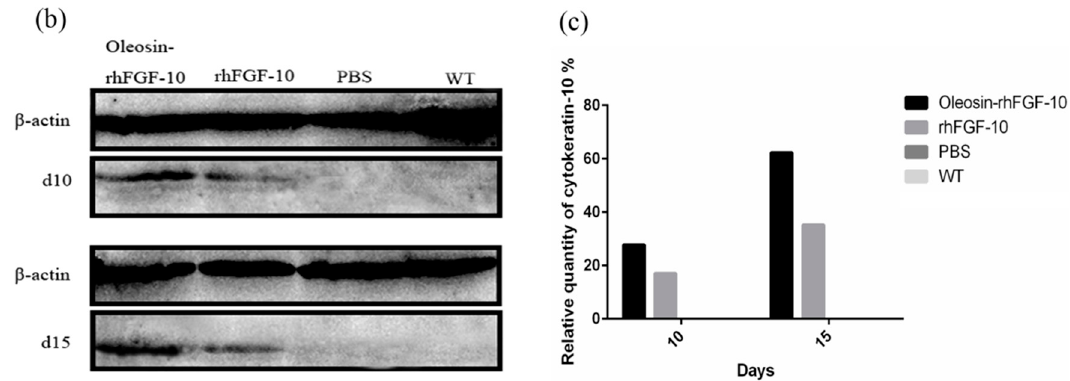
Figure 6. ( a ) Immunohistochemical assay with thecytokeratin-10 in wounds of the four groups. The cytokeratin-10 was detected in regenerated epidermis. The images are shown at 40 × and 100 × magnification; ( b , c ) western blot quantification method for objective evaluation for expressing cytokeratin-10 in regenerated skin.